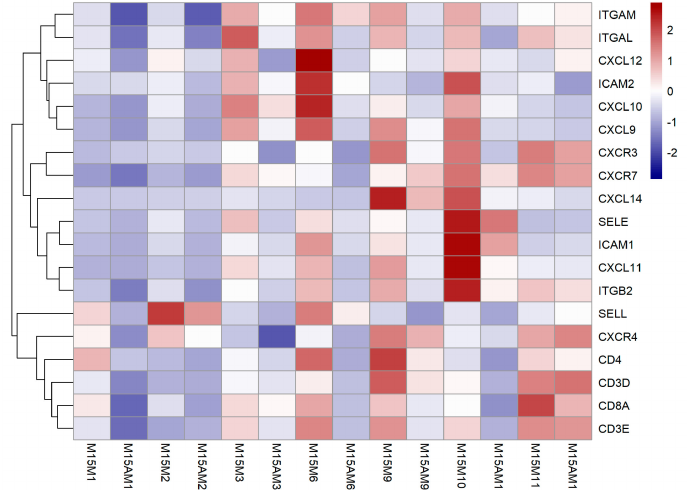
Figure 4. Heatmap for the immune cell recruitment-associated candidate genes (adjusted p -value < 0.05) which were up-regulated at the mesometrial side of uterus on gestational day 15. Each row represents an individual gene, and each column represents a sample. The color legend at the top indicates the level of gene expression, in which red represents a high expression level and blue a low expression level. M15M, gestational day 15 at the mesometrial side of the uterus; M15AM, gestational day 15 at the anti-mesometrial side of the uterus.